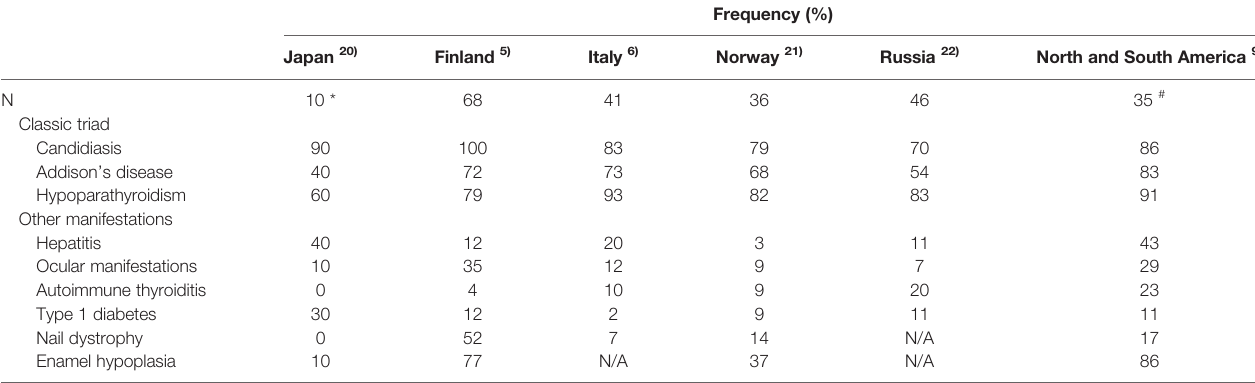
TABLE 3 | Prevalence of disease manifestations in patients with APECED from various countries and